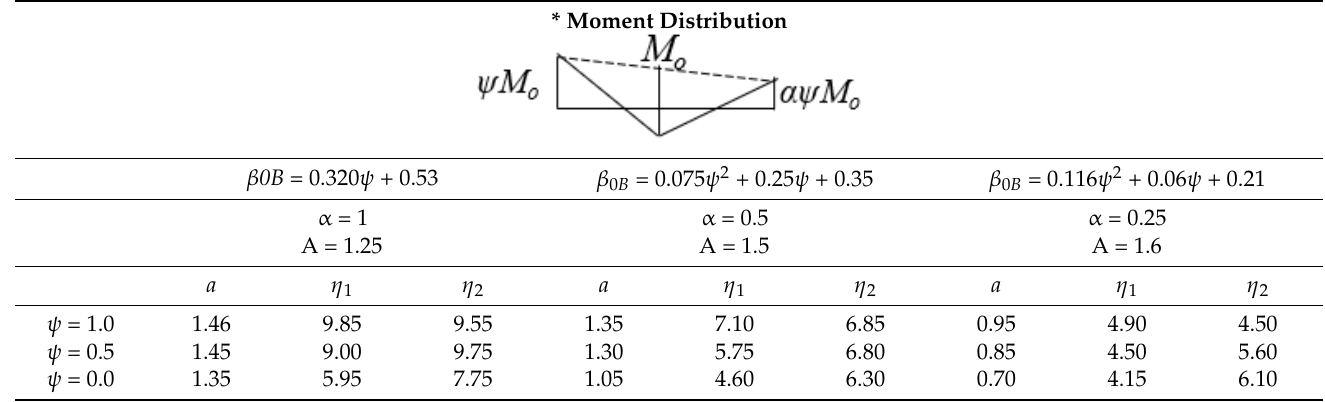
Table 6. Approximate determination of the elastic critical moment for members with concentrated load and end moments. Adapted from Hanswille et al. [117].